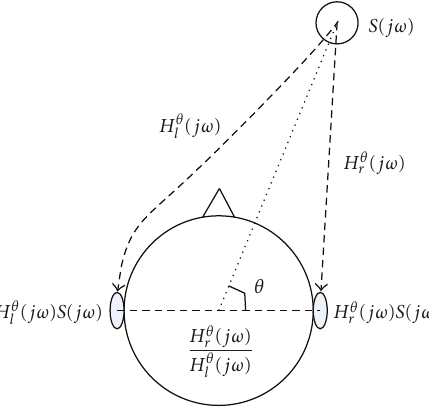
Figure 4: Binaural hearing transfer